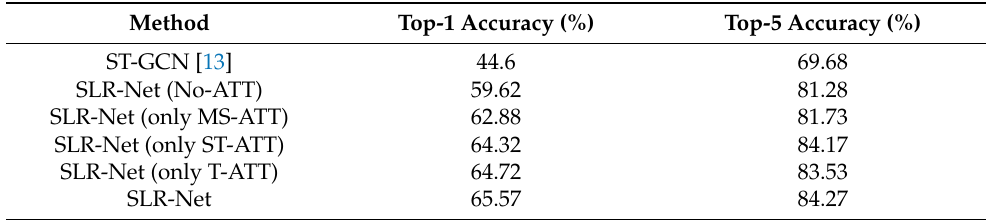
Table 7. Sign languages recognition accuracies by SLR-Net with attention mechanisms, tested on DEVISIGN-L